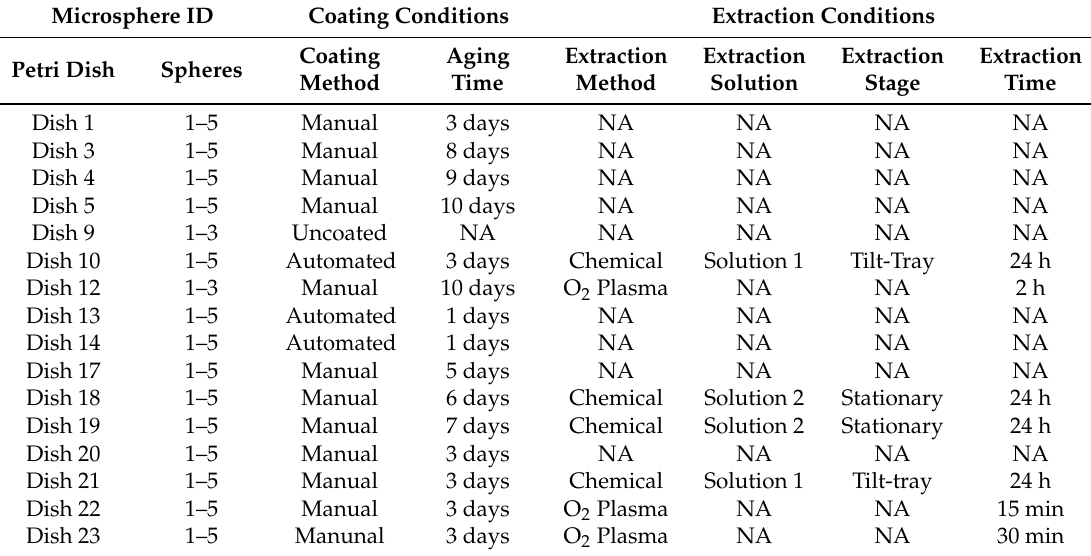
Table 4. Summary of spheres used in this study and their identifications along with tested parameters. All the spheres in a Petri dish were treated exactly the same way as the other spheres in the particular Petri